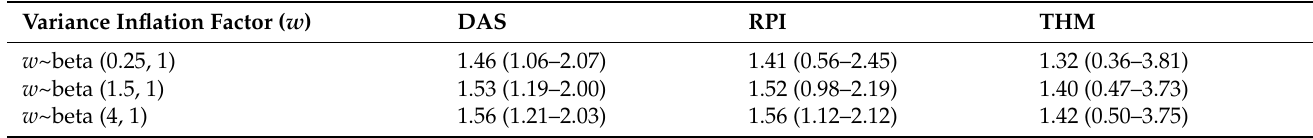
Table 4. Estimated effects and 95% credibility intervals of the risk of diabetic ketoacidosis (DKA) among users receiving sodium/glucose cotransporter 2 (SGLT-2) inhibitors versus active comparators. Variance Inflation Factor ( w ) DAS RPI THM w ~beta (0.25,